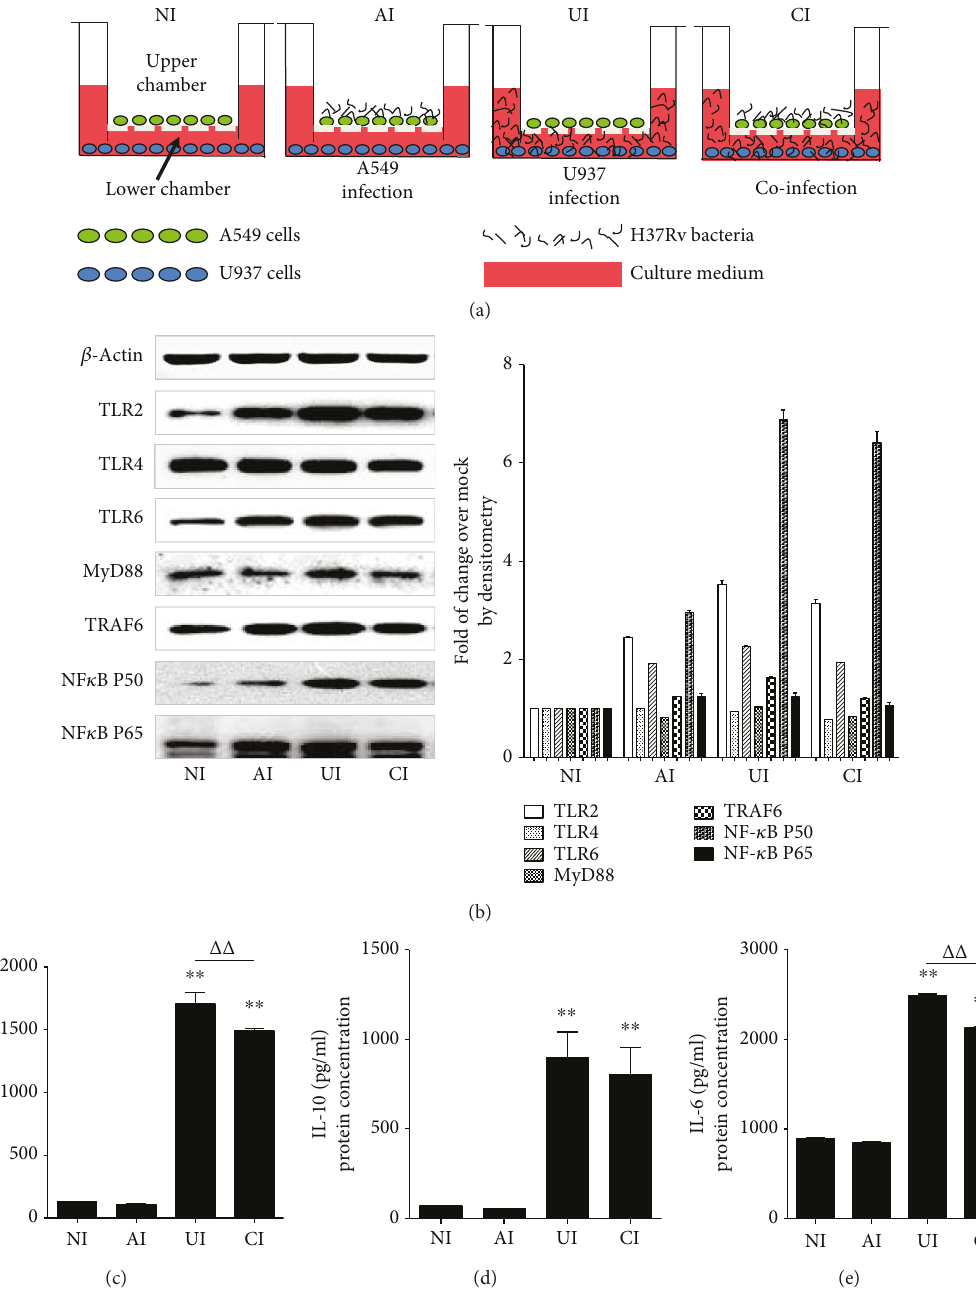
Figure 1: Mtb H37Rv-infected A549 cells reduced TLR signaling activity and cytokine production of U937 cells in response to mycobacterial infection. (a) Illustration of cell culture models used for infection in this study. A549 cells were cultured on the apical surface of transwells at an air-liquid interface state for 24 hours; then the transwell insert was transferred to a well containing PMA-stimulated U937 cells for infection. The coculture model of A549/U937 cells was infected with H37Rv mycobacteria from the upper chamber (A549 cells, AI), lower chamber (U937 cells, UI), or both chambers (A549 and U937 cells, CI) at a MOI of 3 for 18h before the culture medium and U937 cells were harvested for analysis. (b) Representative blots of immunoblotting assay for indicated components of TLR signaling cascade (left panel) and fold of changes of proteins of interest in U937 cells semiquantitatively determined by densitometric assay using ImageJ software Fiji (right panel). H37Rv-infected A549 cells showed an ability to reduce TLR signaling activity in U937 cells in response to mycobacterial infection. Concentrations of TNF- α (c), IL-10 (d), and IL-6 (e) in culture media determined by ELISA. H37Rv-infected A549 cells led a reduction of cytokine production in U937 cells in response to Mycobacteria infection. Error bars represent the standard deviation (SD) from three independent experiments. Compared to noninfection (NI) control, ∗∗ p < 0 01 ; compared to infection of U937 cell alone, ΔΔ p < 0 01 . NI: noninfected control; AI: infection was performed on A549 cell alone; UI: infection was performed on U937 alone; CI: infection was performed on both A549 cells and U937